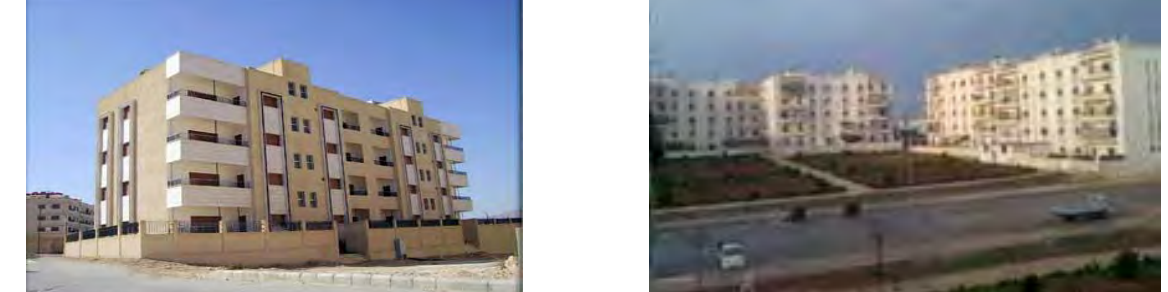
Figure 7: building height of five floors(left) and separation of vehicles from pedestrian (right)